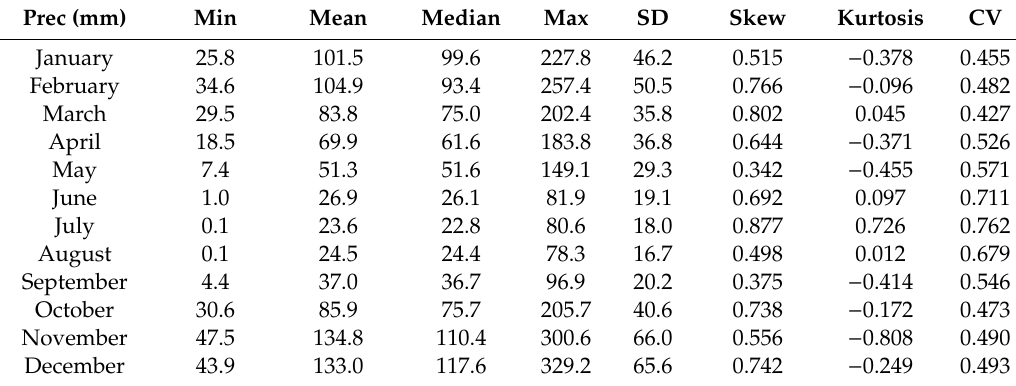
Table 4. The average statistical properties of observed monthly precipitation values (mm). SD is an abbreviation for standard deviation and CV for coe ffi cient of variation (the ratio of the standard deviation to the